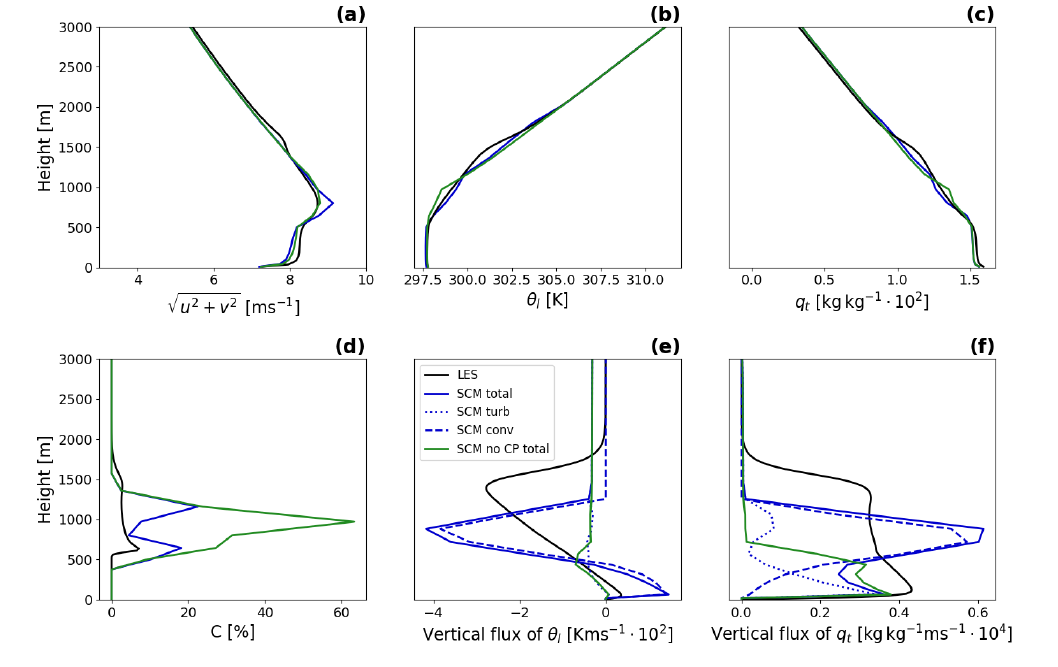
Figure 4. As in Figure 2, but mean vertical profiles of wind speed ( a ), θ l ( b ), q t ( c ), cloud fraction ( d ), and vertical fluxes of θ l and q t from the turbulence scheme and the convection scheme ( e , f ) for the RICO case after 5 h of